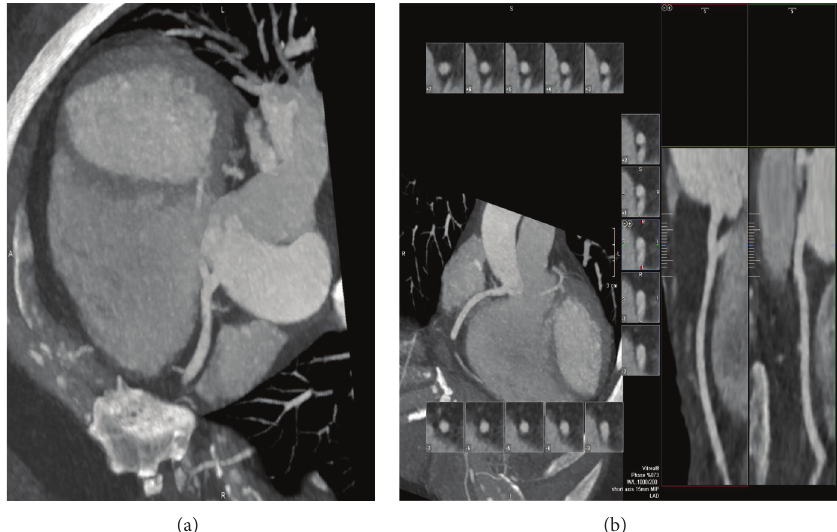
Figure 1: Cardiac computed tomography showing anomalous left main off of the right sinus of Valsalva and subsequent intraseptal course.